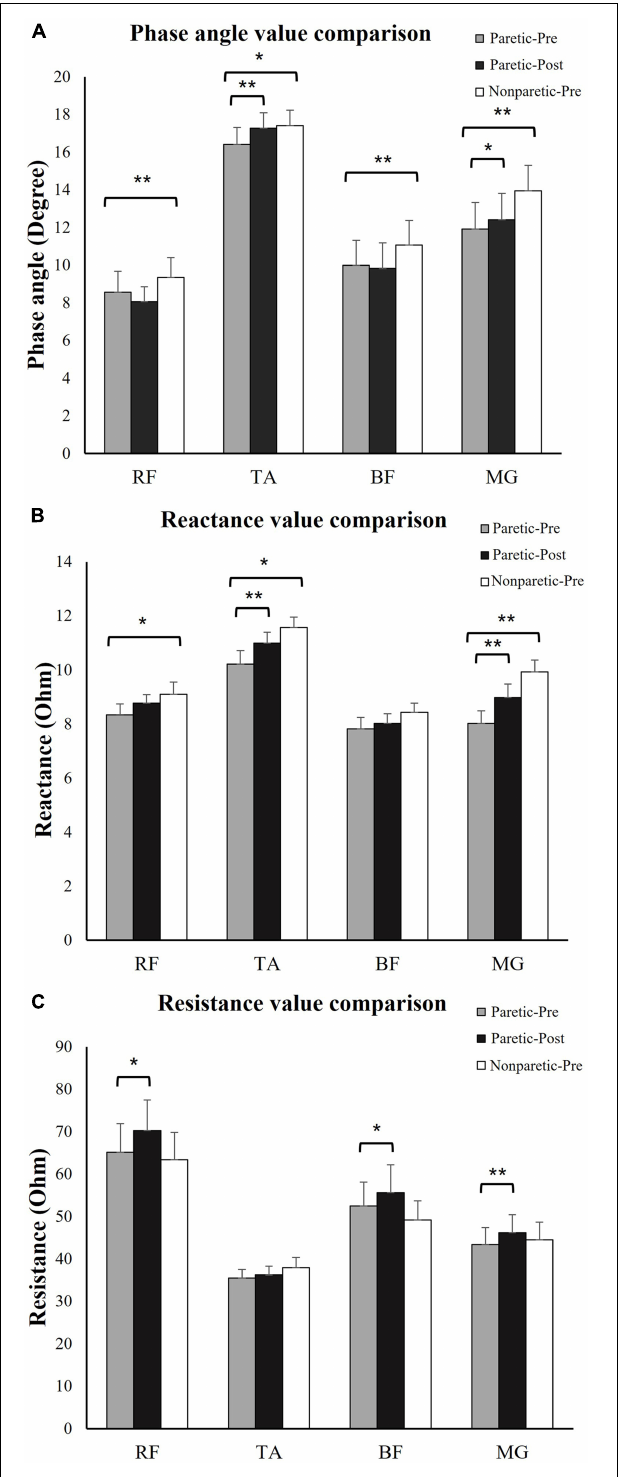
FIGURE 2 | Electrical impedance myography (EIM) parameters comparison. (A) Phase angle ( θ ) comparison: θ was significantly lower in paretic BF, TA, BF, and MG compared to non-paretic side. Immediately after training, θ significantly increased in TA and MG. (B) Reactance ( X ) value comparison: